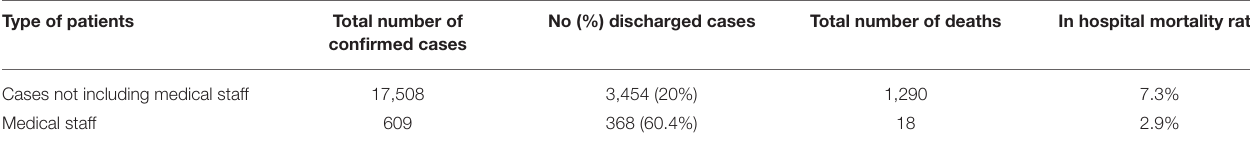
TABLE 3 | Percent of teaching hospital discharges for COVID-19 confirmed cases and in-hospital mortality rate throughout the period (June 1 to July 15, 2020). Type of